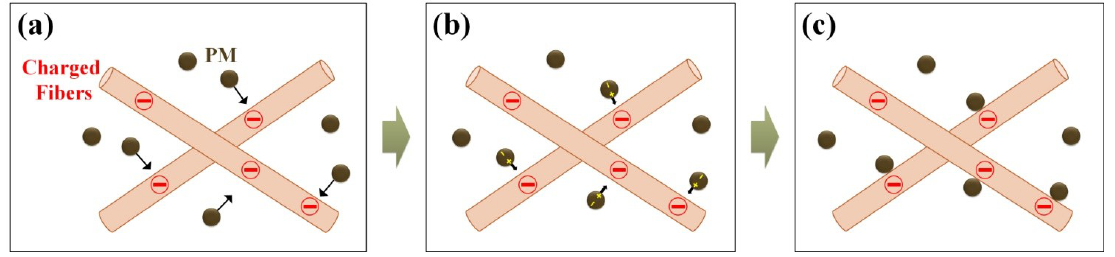
Figure 4. Schematic diagram of a PM-capturing mechanism with three main steps: ( a ) neutral condition of PM charge, ( b ) partially induced PM charge by London dispersion force, and ( c ) PM capture by an electrophoretic force.